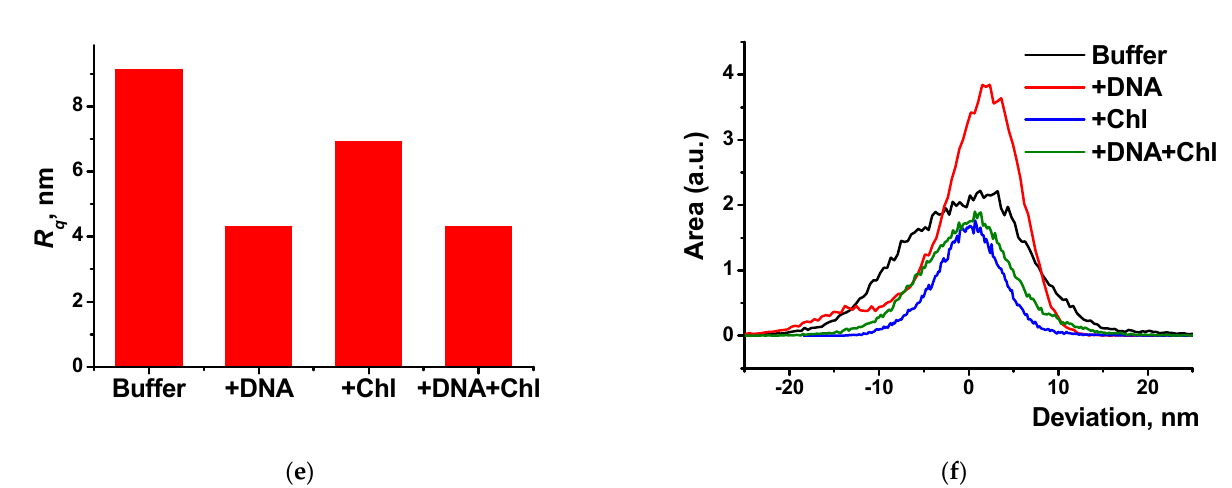
Figure 10. AFM 3D models of the films on the GCE surface covered with Azure A electropolymerized from phosphate buffer ( a , c ), in the presence of 0.2 mg/mL DNA ( b , d ), and in the absence ( a , b ) and in the presence of CHCl 3 ( c , d ); twenty cycles of polymerization. Root mean square values ( e ) and distribution of heights over the 10 × 10 μ m 2 region for the polymers deposited from the buffer and that with addition of DNA (+DNA), saturated with chloroform (+Chl), and that containing both DNA and chloroform (+DNA + Chl) ( f ).